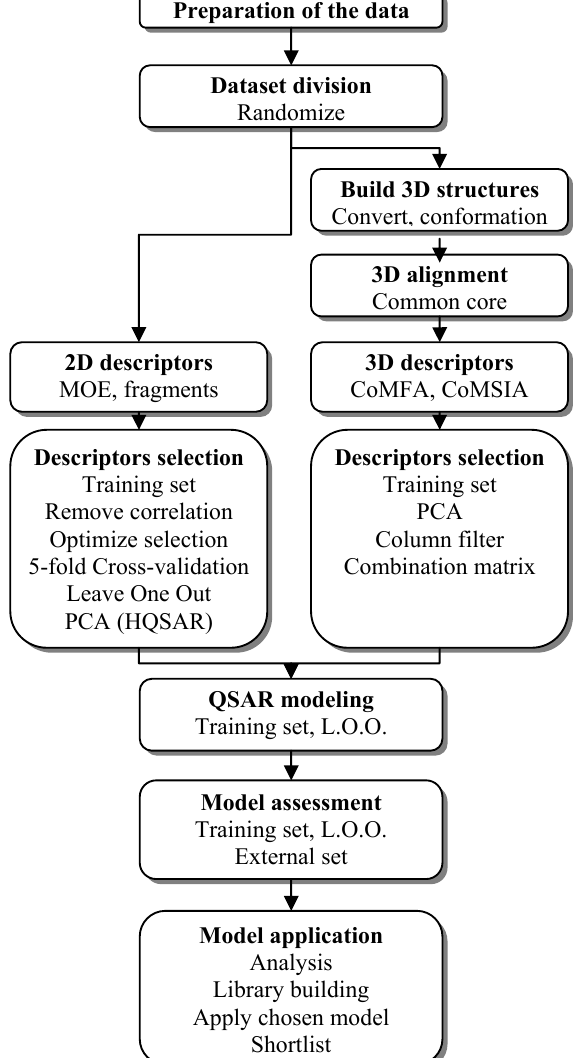
Figure 5. Process of combined QSAR studies. Preparation of the